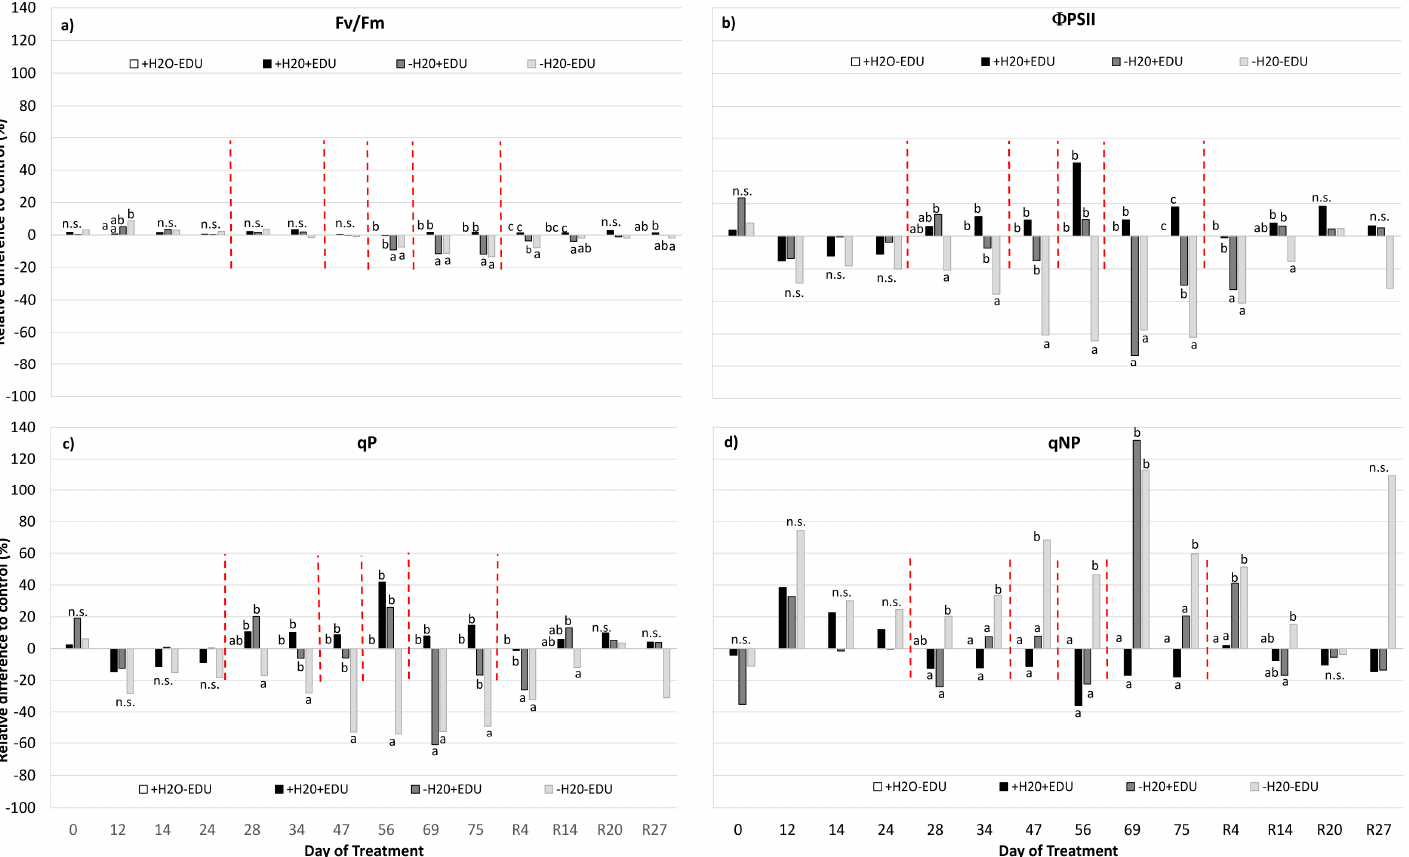
Figure 4. ( a ) Maximum quantum yield of PSII ( F v / F m ); ( b ) effective quantum yield of PSII ( Φ PSII); ( c ) photochemical quenching (qP); and ( d ) non-photochemical quenching (qNP), measured during the experimental period. On the horizontal axis, the Day of Treatment is reported (0–75 = days from the last irrigation and R4, R14, R20, R27, days from rewatering of the water-stressed mesocosms). Vertical red dashed bars indicate the dates on which the EDU treatment was applied. For each measurement date, data are expressed as the relative difference with respect to the control set (+H 2 O − EDU), and different letters indicate statistically significant differences between means (9 < N < 30, see Supplementary Table S1).